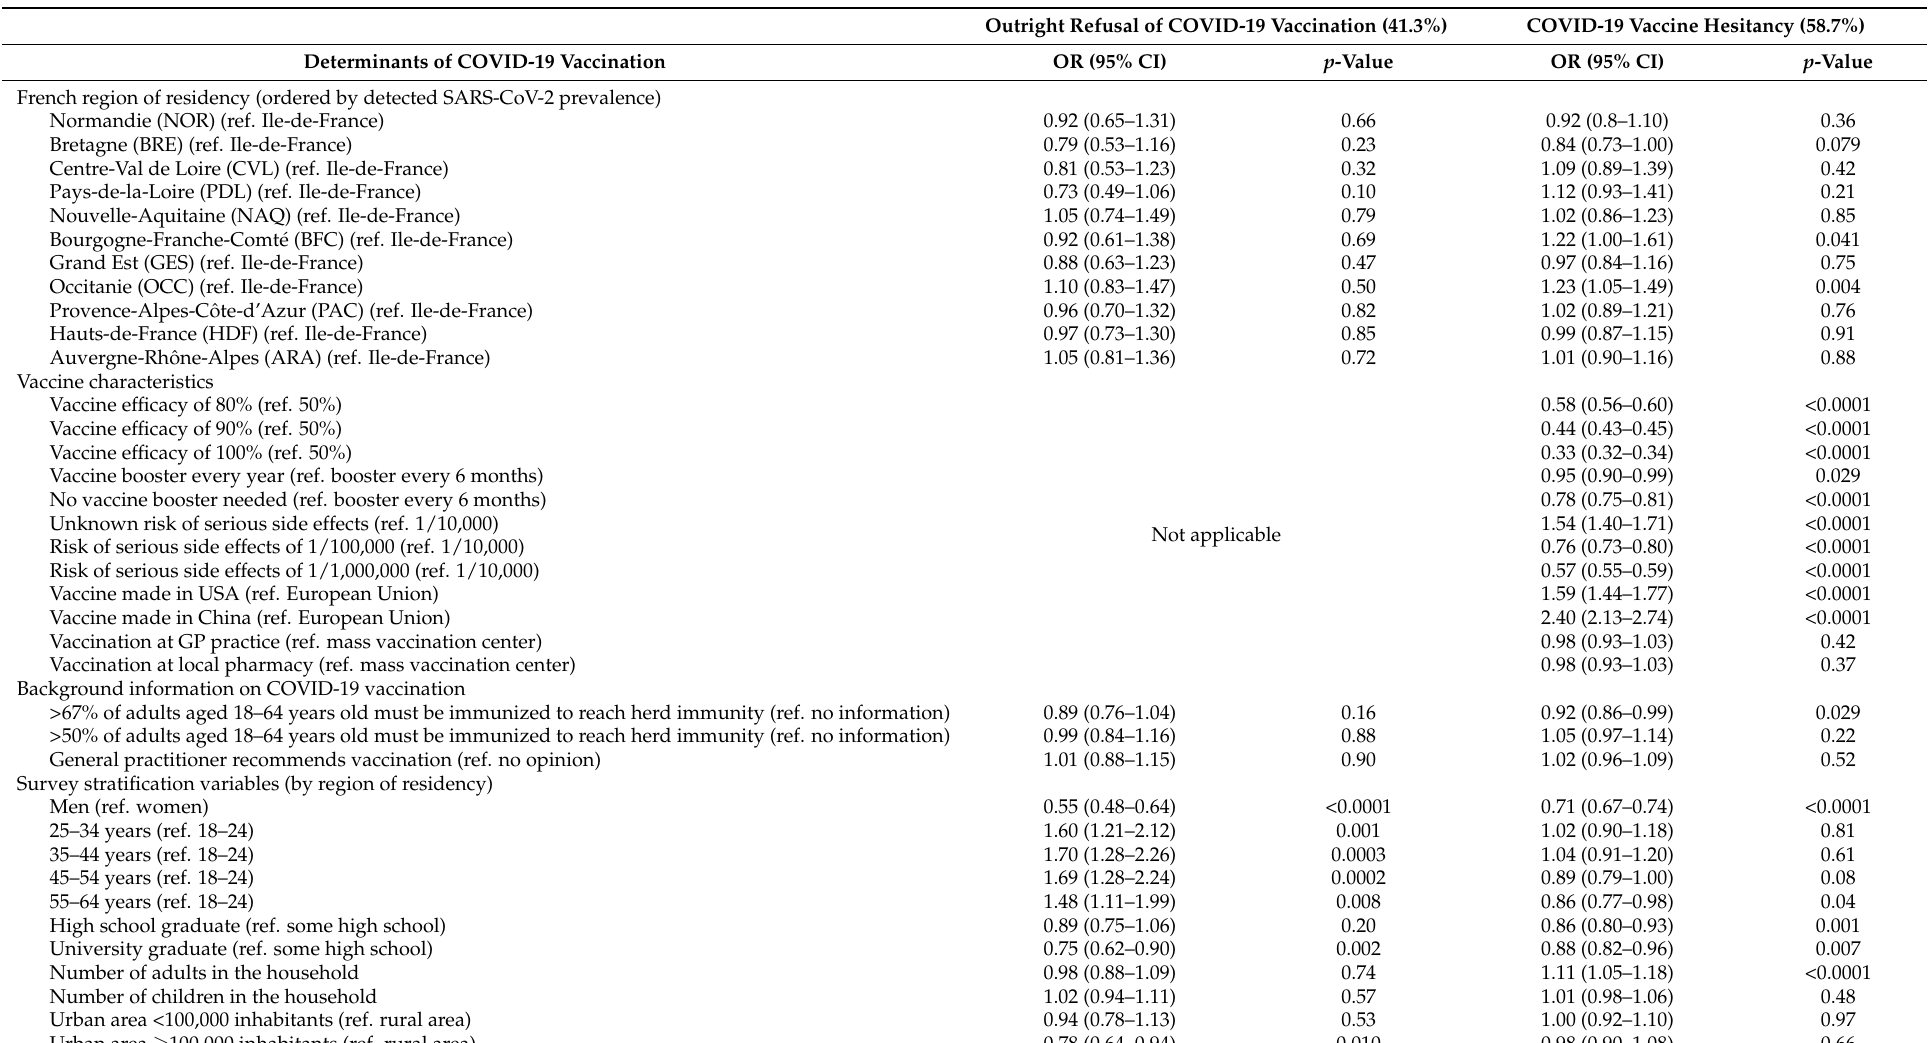
Table 1. Behavioral model of COVID-19 vaccination in the French working-age population without prior SARS-CoV-2 infection in December 2020 ( n =